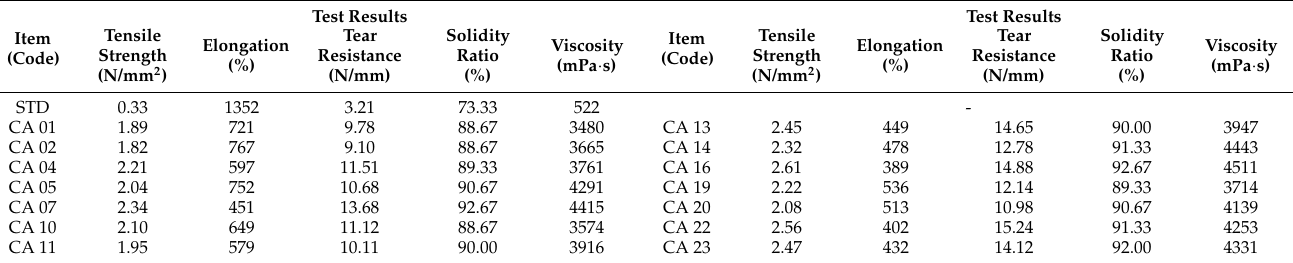
Table 13. Single mixture ratio additive properties.